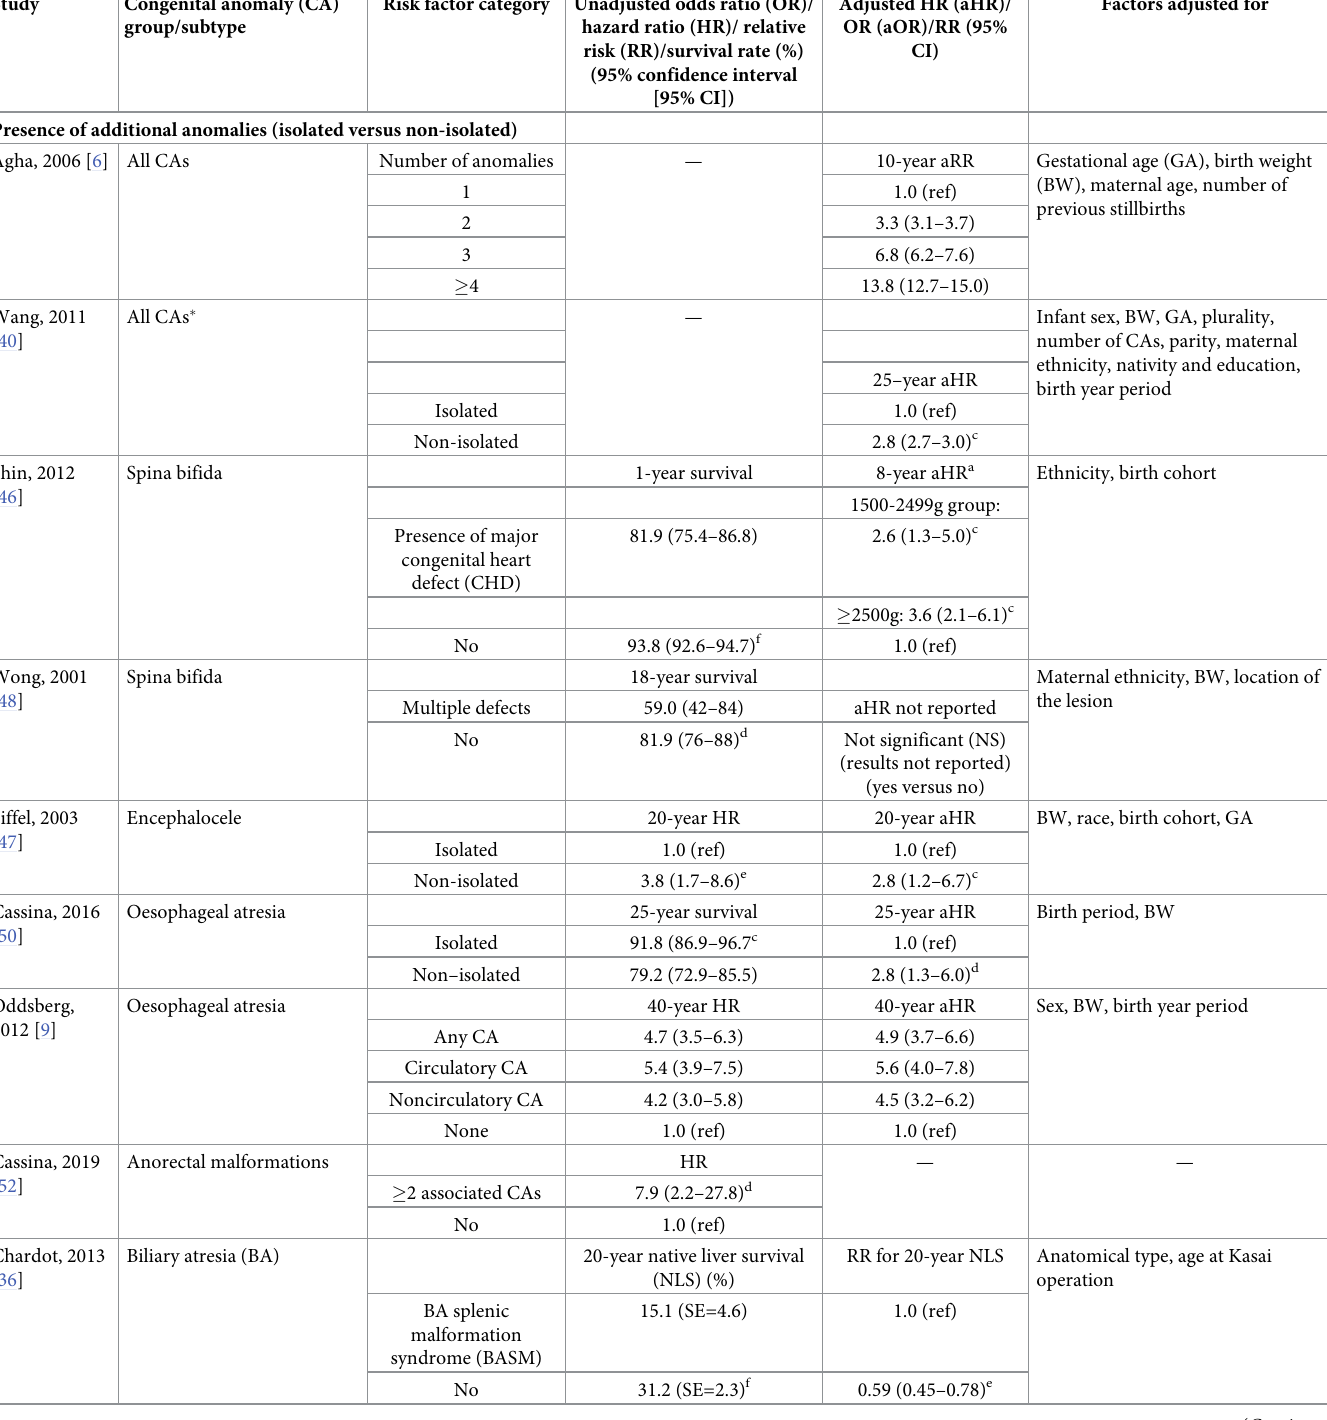
Table 5. Predictors of survival/mortality in the included studies that explored factors associated with long-term survival at different age points beyond 1 year of life.